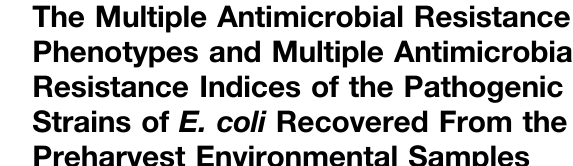
Frontiers in Environmental Science |